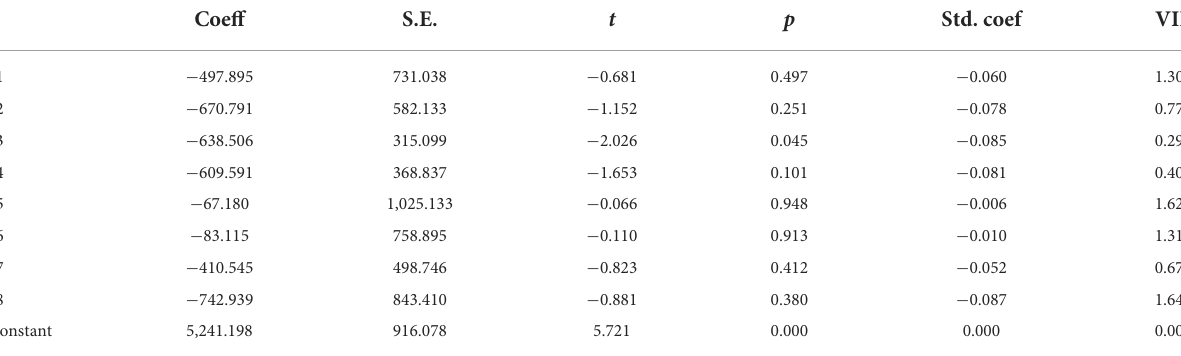
TABLE 6 Ridge regression analysis between the number of scarlet fever cases and each NPI in mainland China from January 2011 to May